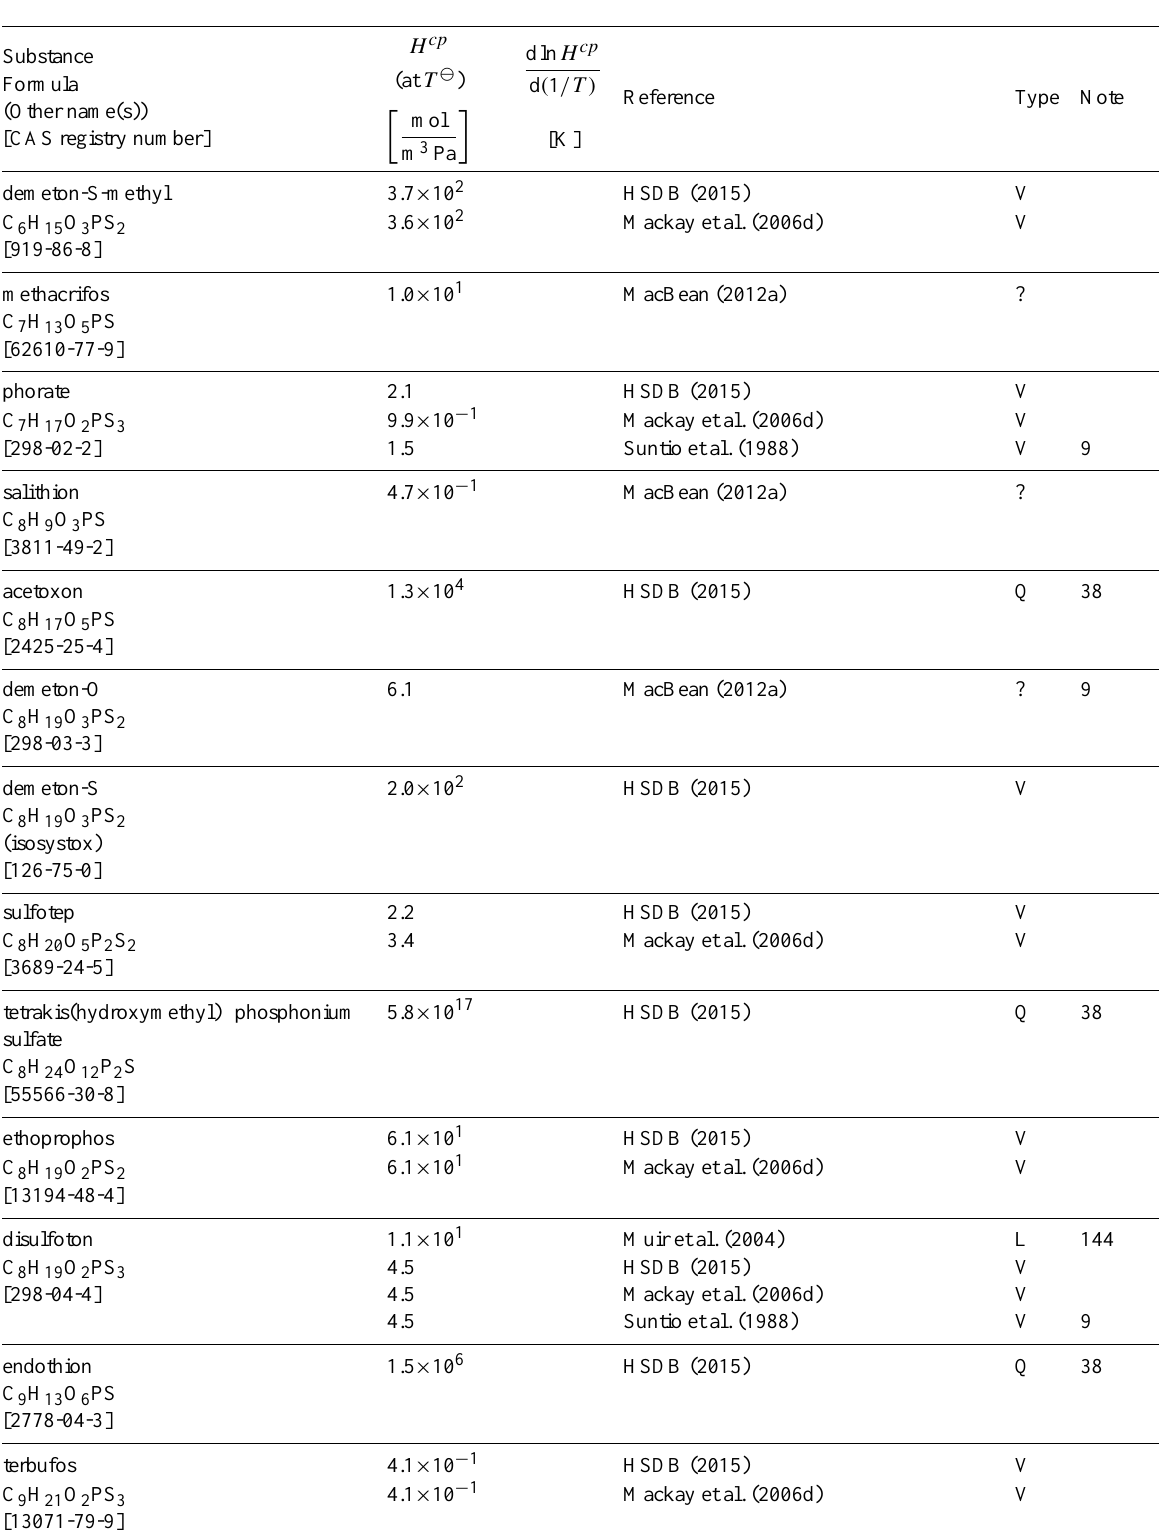
Table 6: Henry’s law constants for water as solvent